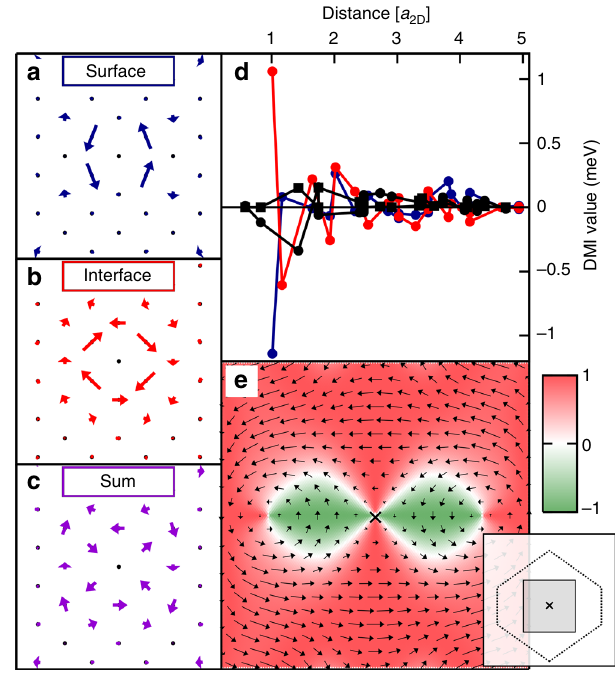
Fig. 3 DM vectors in real and reciprocal space for 2Fe/W(110). DM vectors D 0 j between atoms at site 0 and j in a the surface, b the interface Fe layer and c the sum of both superimposed at the surface atoms in 2Fe/W(110), with atom site 0 at the center of each panel. DM vectors D 0 j are placed at atom sites j for visual convenience. d sign D ij ð Þ φ D ij ð Þ in-plane component of the DM vector, for the intralayer DM interaction in the surface Fe layer ( blue ), the interface Fe layer ( red ) and the interlayer DM interaction ( black circles ) for the fi rst 21 shells of neighbors. In addition, the out-of-plane component of the interlayer DM interaction is shown ( black squares ). e D ( q ) for q -vectors close to the center of the two- dimensional Brillouin zone ( gray marked area in inset) for a homogeneous spin-spiral in both layers. The color code represents ð D ð q ÞÞ φ = ð D ð q ÞÞ